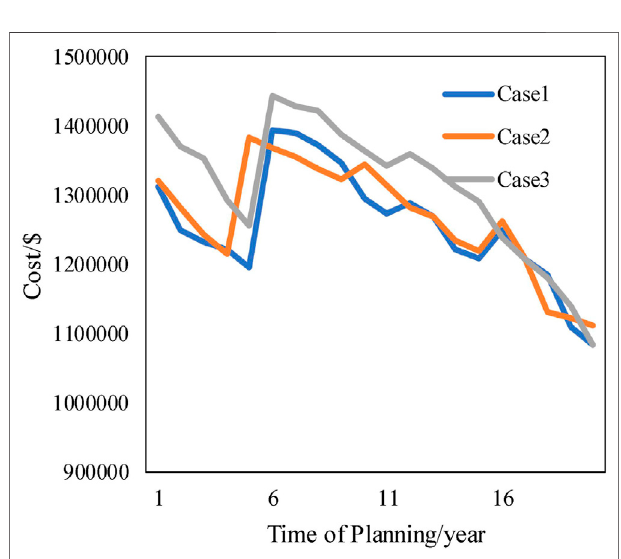
FIGURE 9 | Comparison of planning costs for each